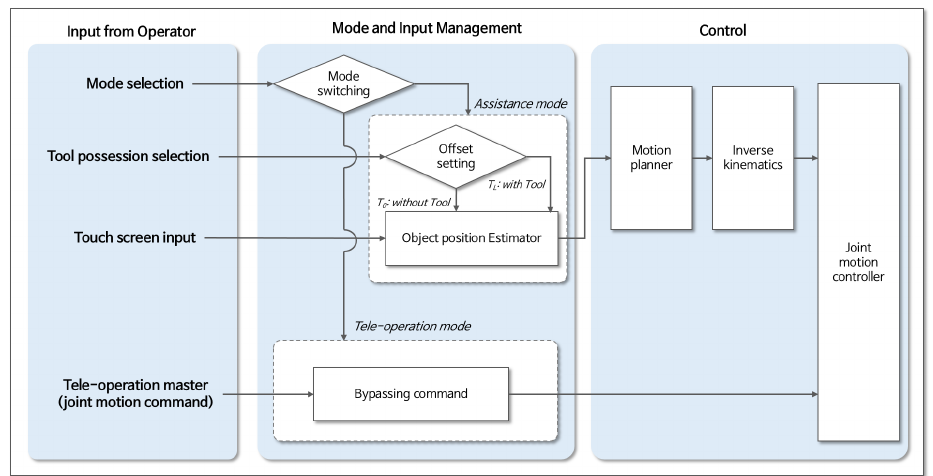
Figure 10. Overall control structure for assisted